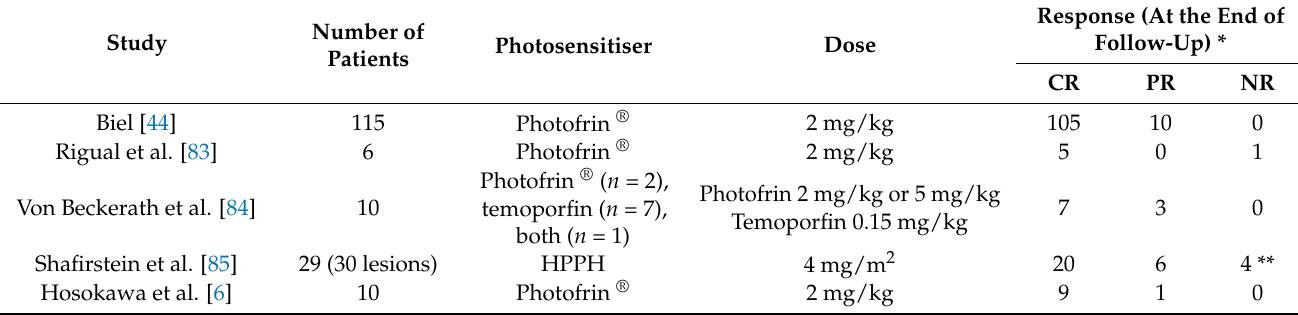
Table 4. Summary of recent studies where PDT was given to patients with laryngeal cancer.